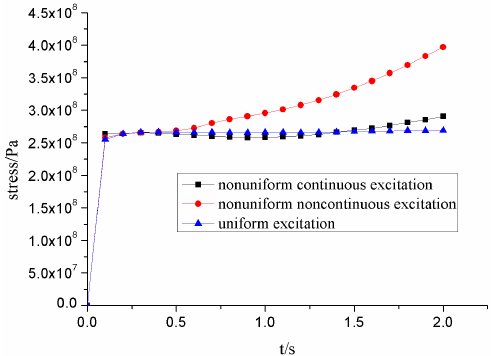
Figure 5. Comparison of stress at the middle of the pipeline.